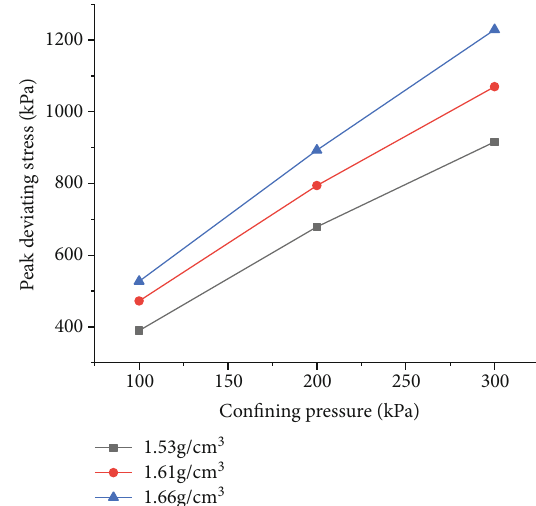
Figure 7: The relation curve between peak strength and con fi ning pressure in PFC